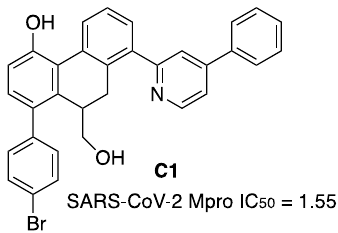
Figure 19. Dihydrophenanthrene C1 .